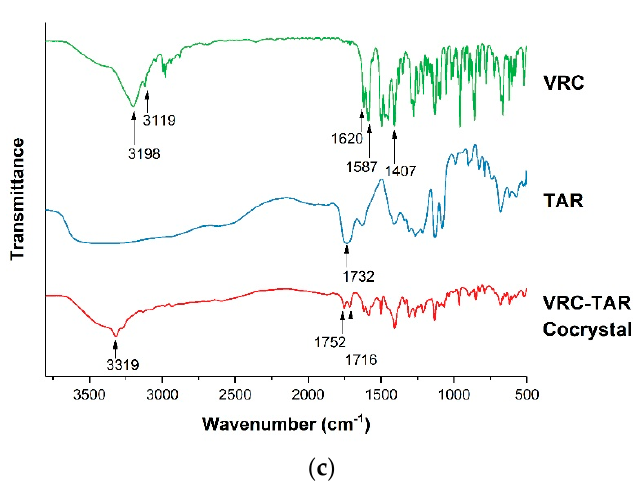
Figure 9. Solid-state characterization of the VRC-TAR cocrystal system: ( a ) PXRD patterns, new peaks are marked with *; ( b ) DSC thermograms; and ( c ) Fourier-transform infrared spectroscopy (FTIR) patterns.